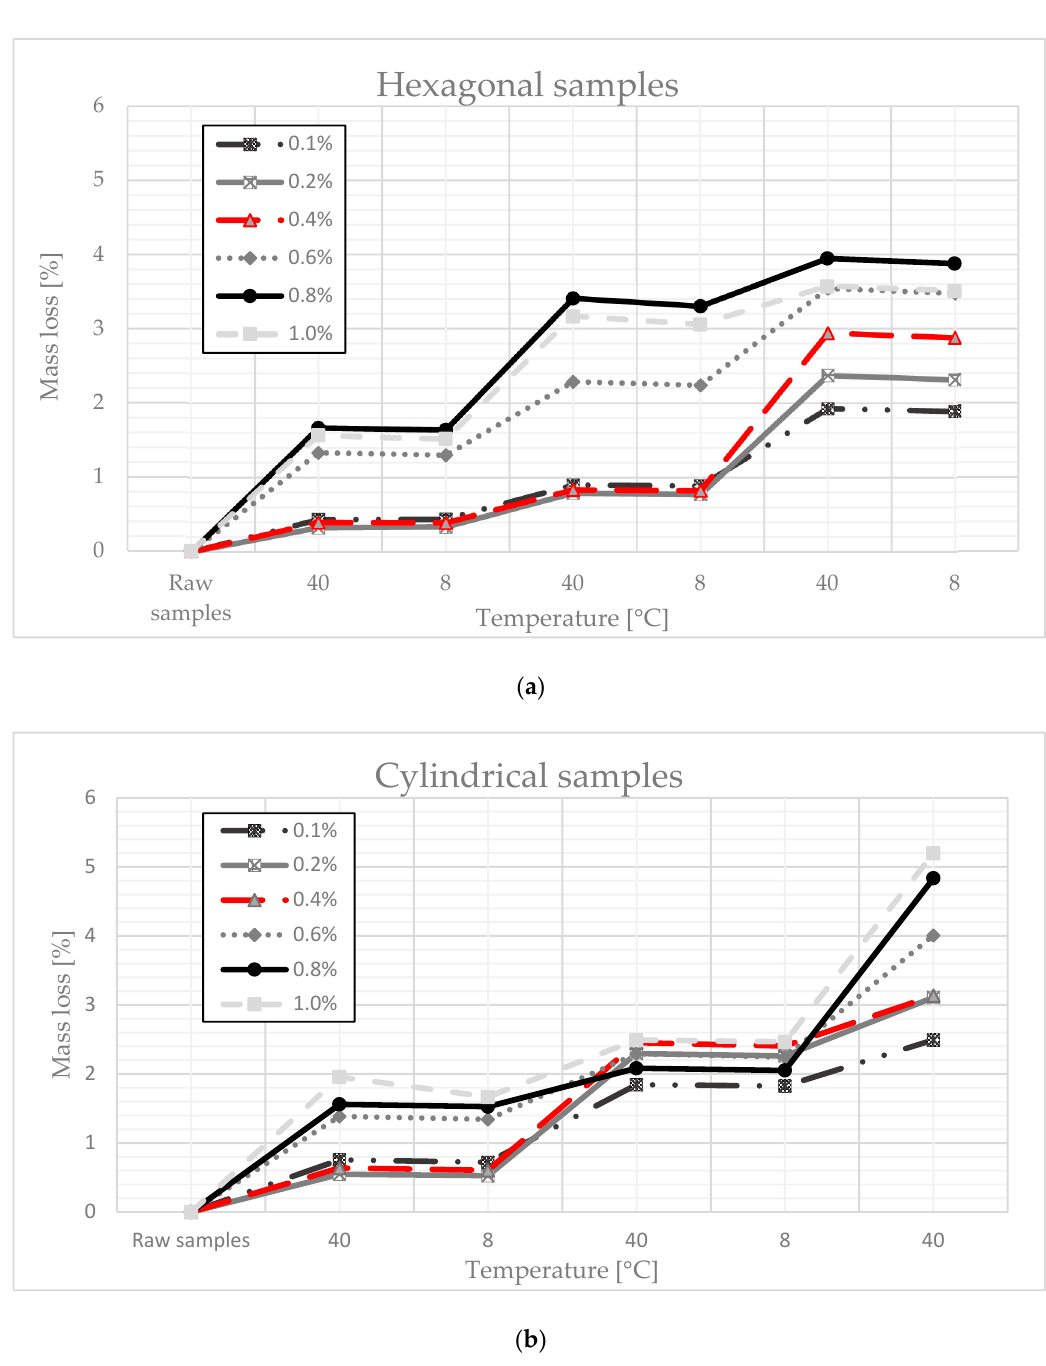
Figure 1. ( a ) Mass loss due to changing temperature conditions (hexagonal samples). ( b ) Mass loss due to changing temperature conditions (cylindrical samples).